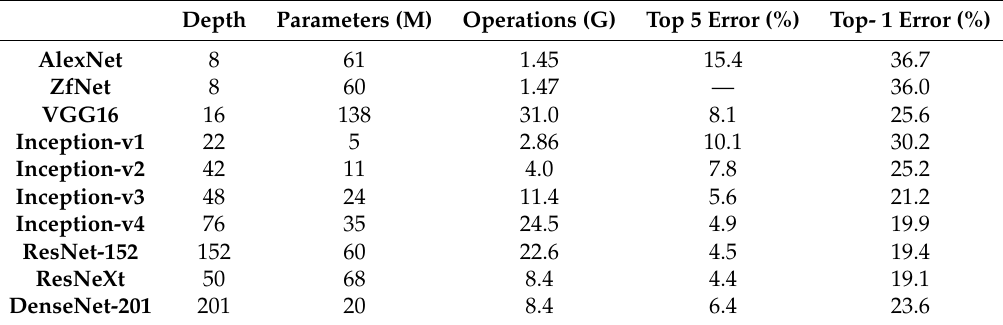
Table 2. Summary of popular accuracy-oriented DNN